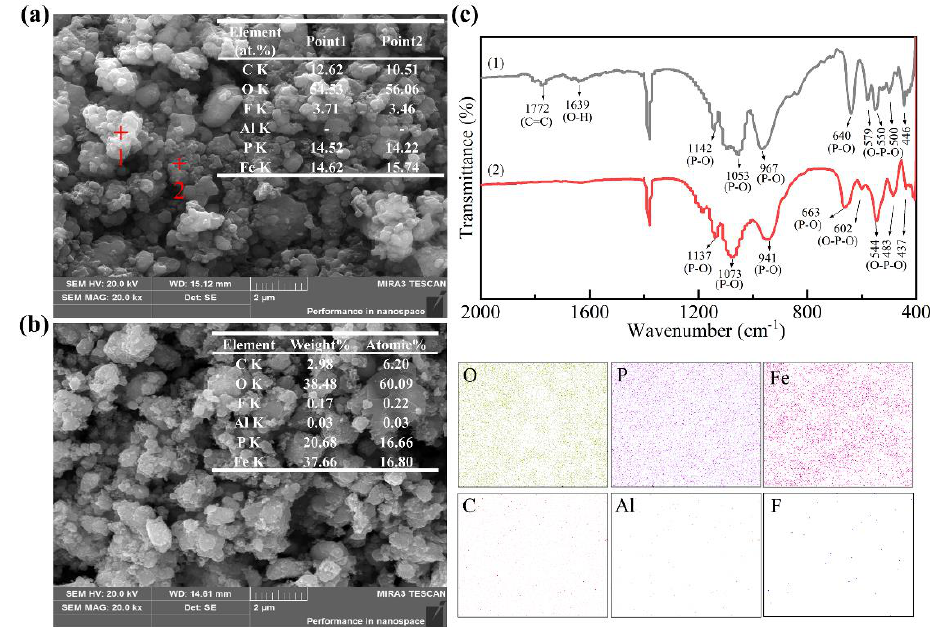
Figure 12. SEM-EDS and FT-IR spectra of raw cathode materials and calcined cathode materials under optimized condition. ( a ) SEM image of raw cathode materials; ( b ) SEM image of calcine cathode